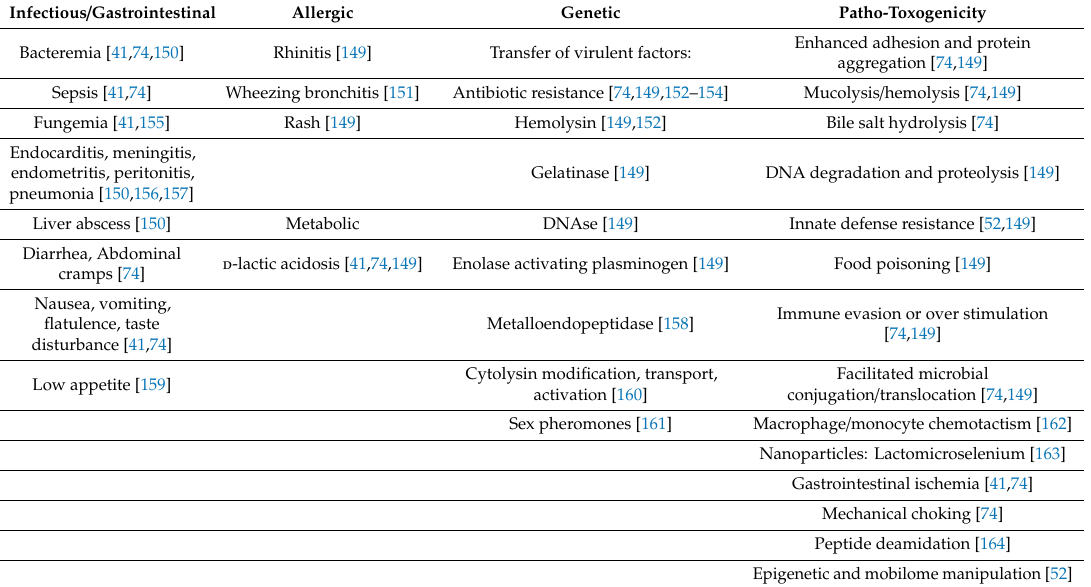
Table 2. Summary of the reported toxic, unintended, adverse e ff ects following probiotic